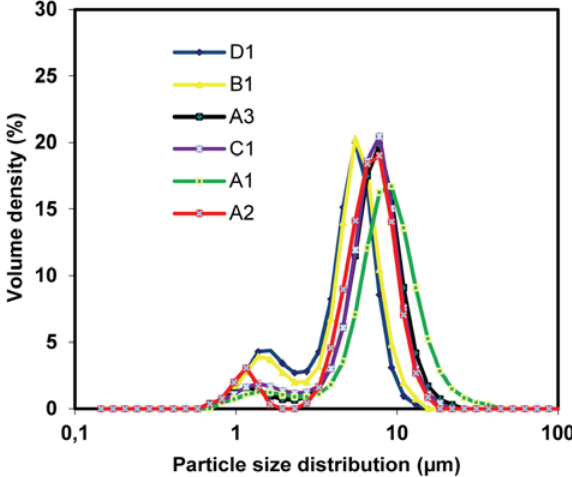
Figure 2. Particle size distribution of microcapsules differing in composition (A1, A2, A3, B1, C1,